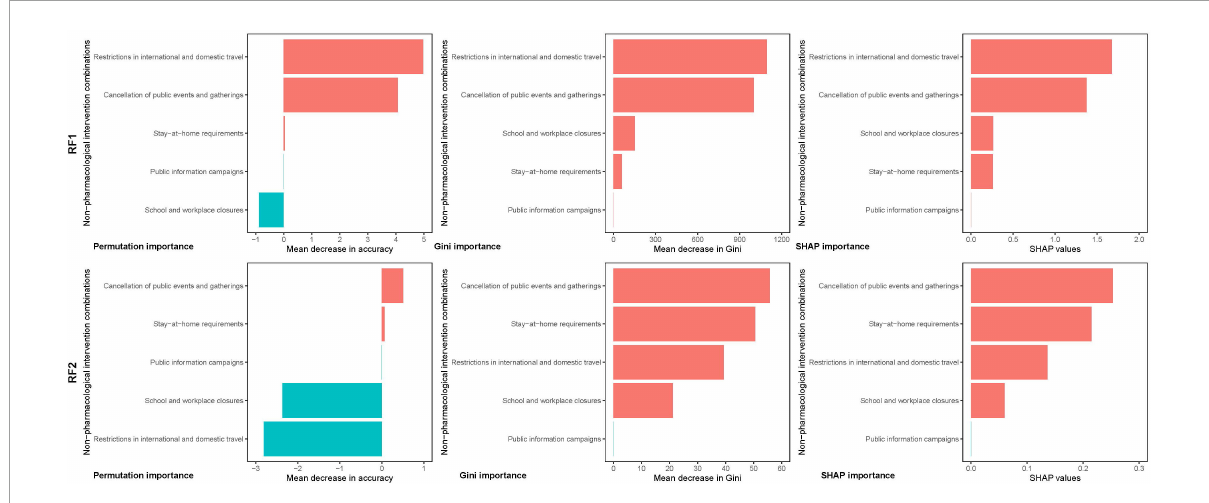
FIGURE2 Ranking of the importance of NPI combinations to COVID-19